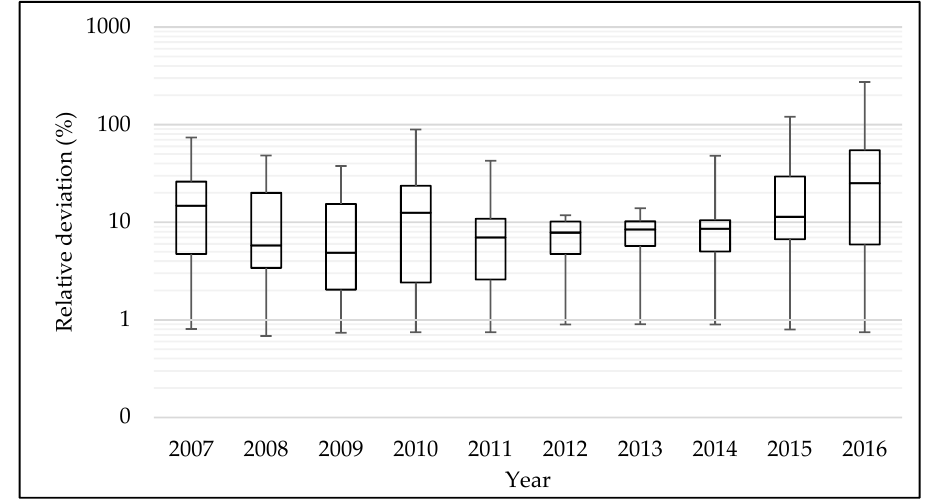
Figure 15. Relative deviation trough 2007 to 2016—GLUE.